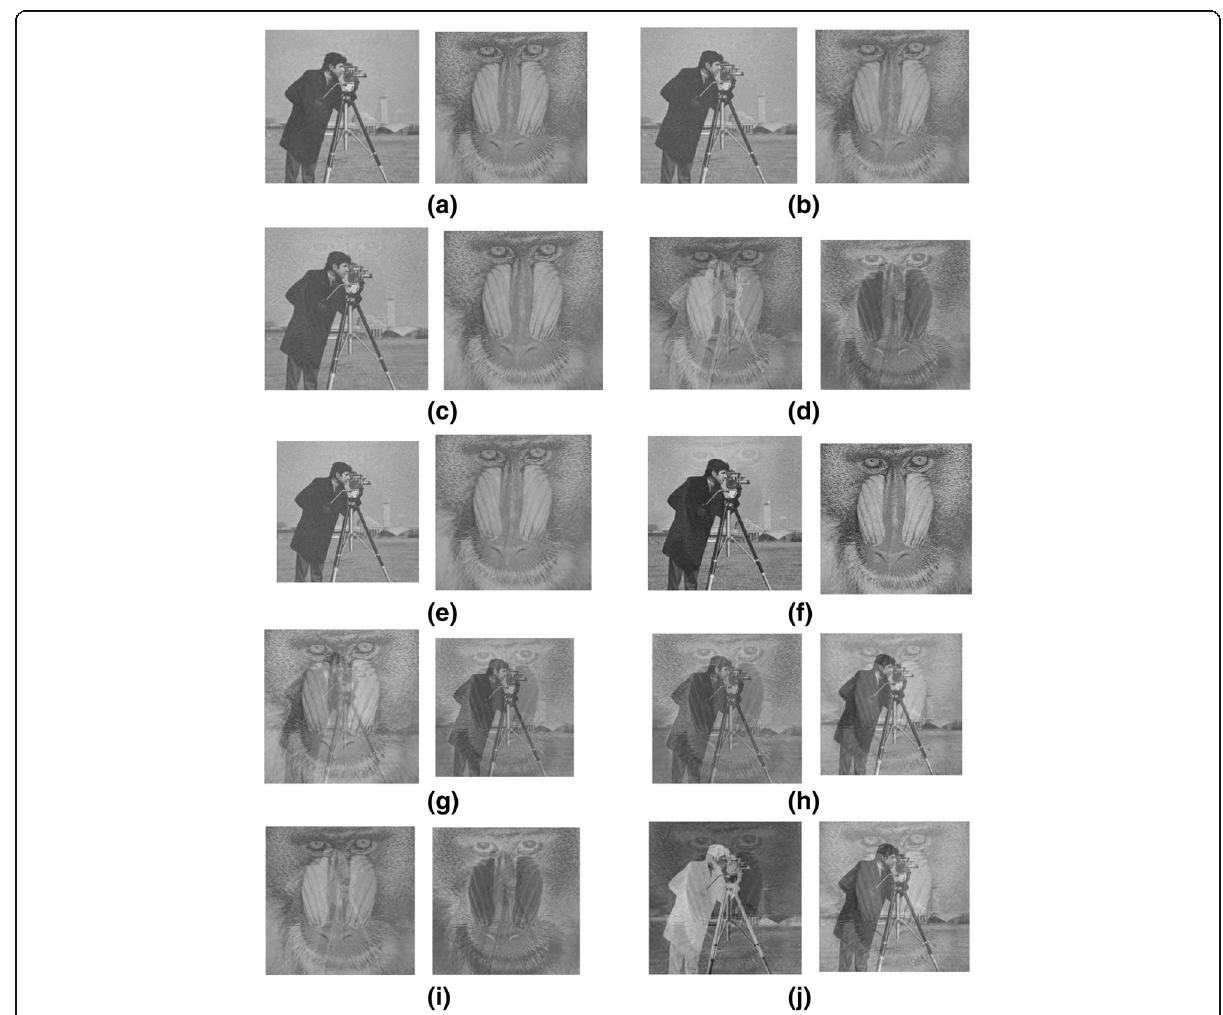
Fig. 10 Estimated results of separated image at noise level 4 dB. a Proposed method (FRT with pyramid). b FRT without pyramid. c DWT with pyramid. d Time with pyramid. e DWT without pyramid. f Time without pyramid. g DCT with pyramid. h DST with pyramid. i DCT without pyramid. j DST without pyramid